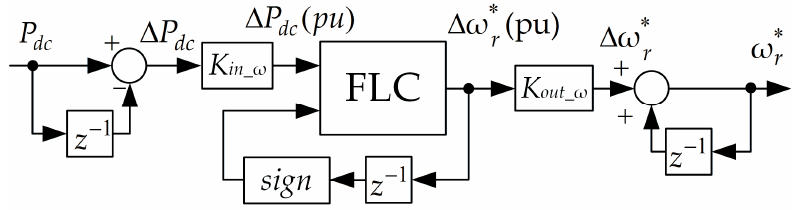
Figure 4. Block diagram of the FL-based WT MPPT algorithm.